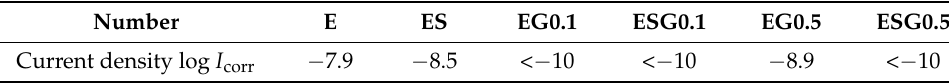
Figure 7. Tafel polarization curves of E, EG0.1, ESG0.1, ES, EG0.5, and ESG0.5. Table 4. Current density of E, EG0.1, ESG0.1, ES, EG0.5, and ESG0.5.